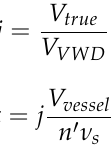
Figure 12. The filling using VWMs for cube (side length = 100 cm), cylinder (diameter = 100 cm, height = 200 cm), and sphere (diameter = 100 cm). ( Left ): The quantity difference between the actual maximal filling number and the filling number with standard deviation. ( Right ): The relative standard deviation for each filling was repeated five times.